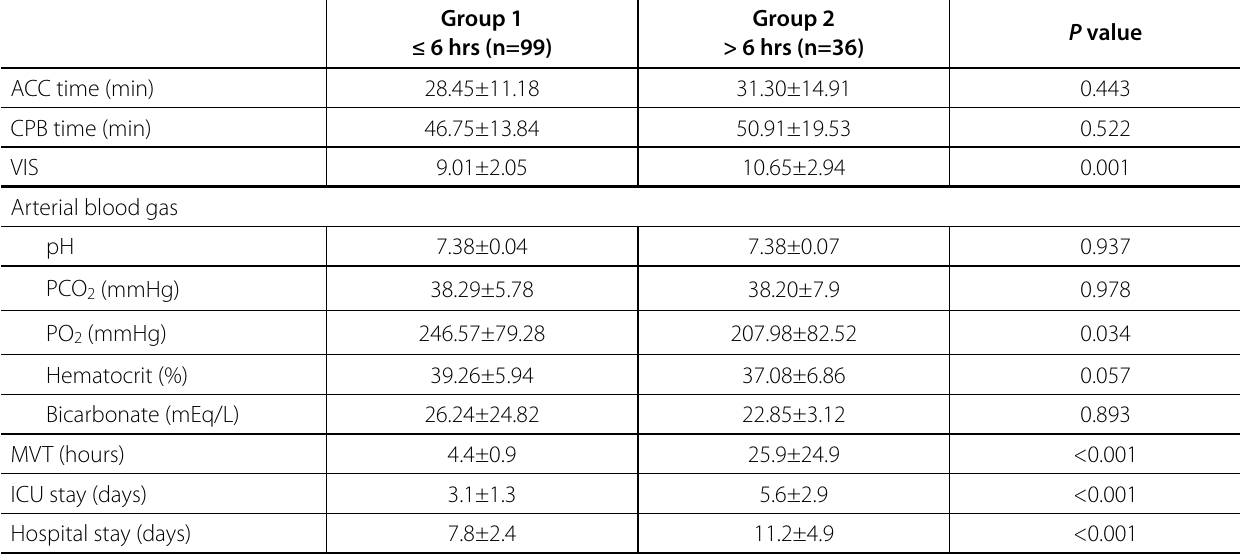
Table 2. Intraoperative and postoperative